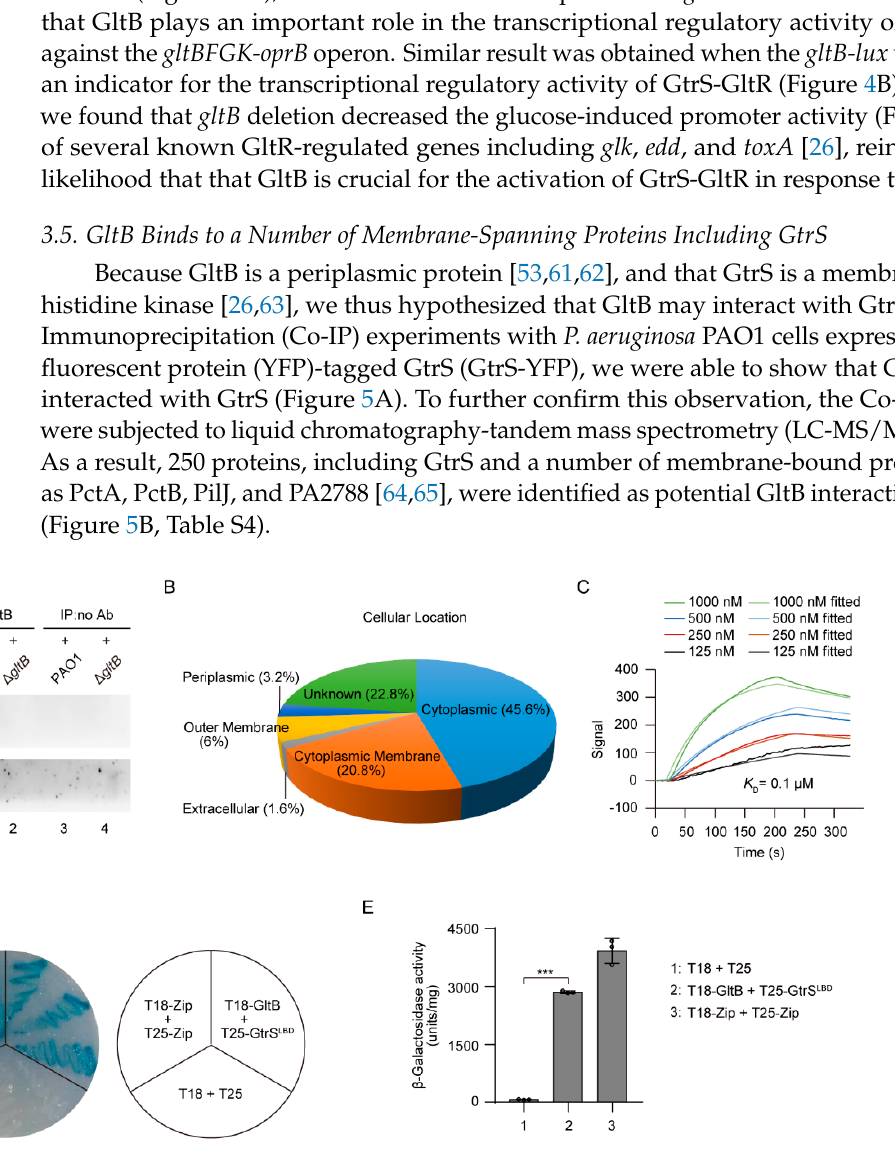
Figure 5. GltB can form a complex with GtrS. ( A ) Western blot image showing the co-Immunoprecipitation of GltB and GtrS-YFP. Whole cell extracts from WT PAO1 and ∆ gltB mutant strains expressing gtrS -YFP were immunoprecipitated with (lanes 1, 2) or without (lanes 3, 4) anti-GltB antibody. ( B ) Categories of the putative GltB-binding proteins identified by co-Immunoprecipitation coupled with mass spectrometric (CoIP-MS). The identified proteins were classified into extracellular, outer membrane, periplasmic, cytoplasmic membrane, cytoplasmic, and unknown according to their potential cellular location (http://www.pseudomonas.com/ accessed on 1 May 2020). Percentage of proteins was indicated in the graph. ( C ) Surface plasmon resonance (SPR) analysis showing the interaction of 6His-GltB with 6His-GtrS LBD . Analysis performed in TraceDrawer using a 1:1 binding interaction model. K D , equilibrium dissociation constant. (D and E) Bacterial two-hybrid (BACTH) assays assessing the interaction of GltB and GtrS LBD . In ( D ), E. coli BTH101 recombinants bearing indicated combinations of plasmids were plated on selective media with maltose as the unique carbon source, and incubated at 30 °C for 6 days; in ( E ), the expression of β -galactosidase activity was examined in E. coli BTH101 recombinants bearing indicated combinations of plasmids cultured in LB broth containing 0.5 mM isopropyl-1-thio- β -d-galactopyranoside (IPTG) for 12 h, and data represented mean ± SD from n = 3 biological replicates (*** p < 0.001; Student’s two-tailed t -test). T18C/T25 (negative control plasmid), T18C-zip/T25-zip (positive control plasmid).